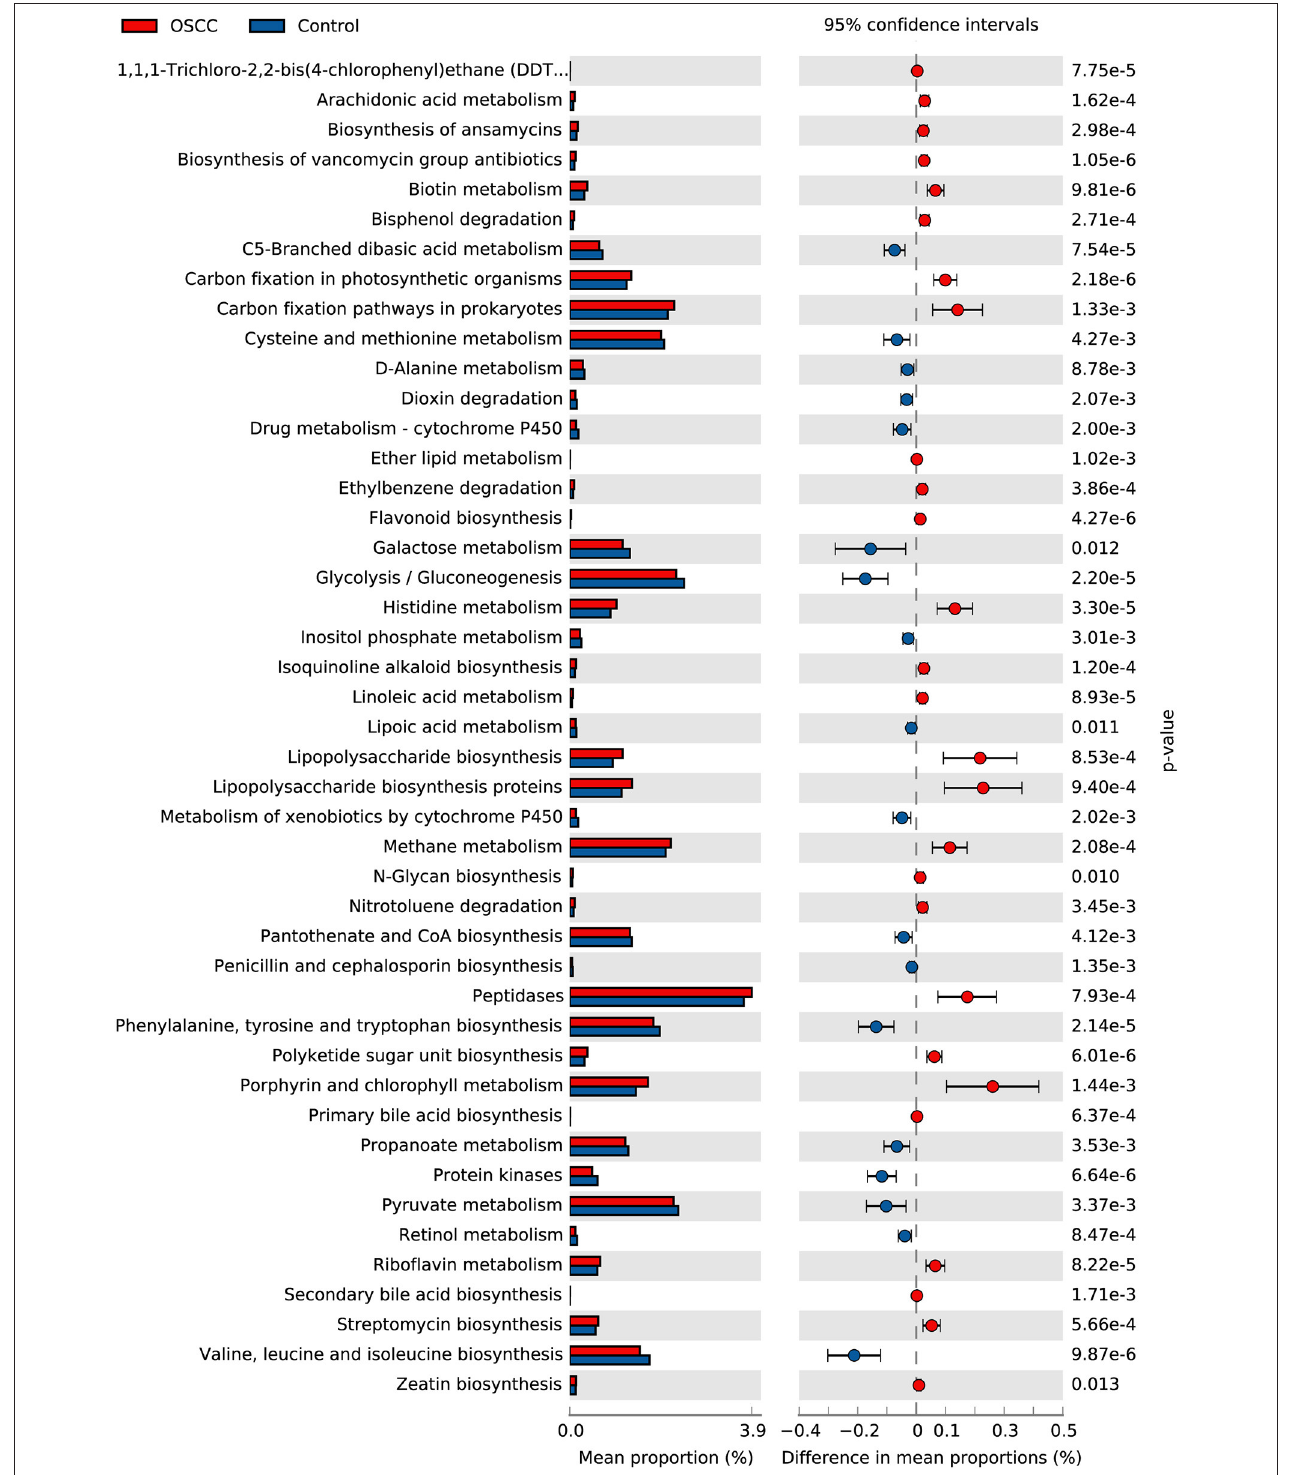
FIGURE 5 | Comparative functional profile of oral microbiota between OSCC and Control groups. Microbial functions were predicted using PICRUSt at the third level of the KEGG pathway, and statistically analyzed by STAMP. KEGG pathways with significant abundance difference ( P < 0.05) are shown.